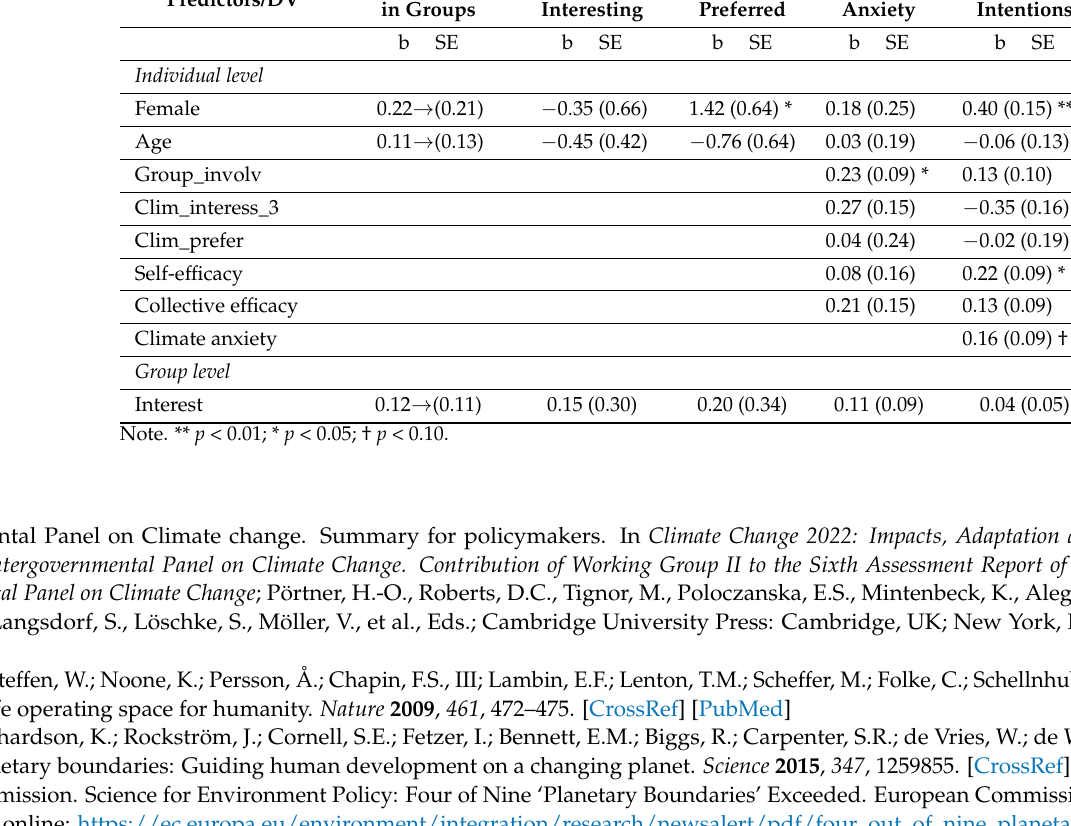
Table A5. Results of multilevel regressions, with the score of perceived interest as group-level predictor.